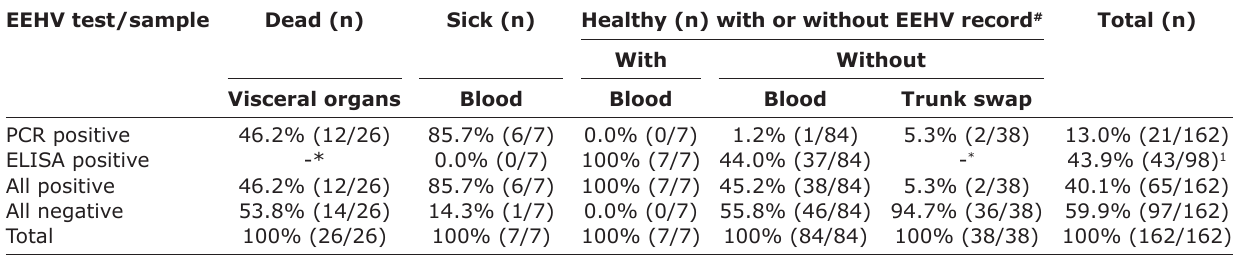
Table-1: Occurrence of EEHV detected by PCR and ELISA in EEHV suspected dead or sick elephant and healthy elephants. EEHV